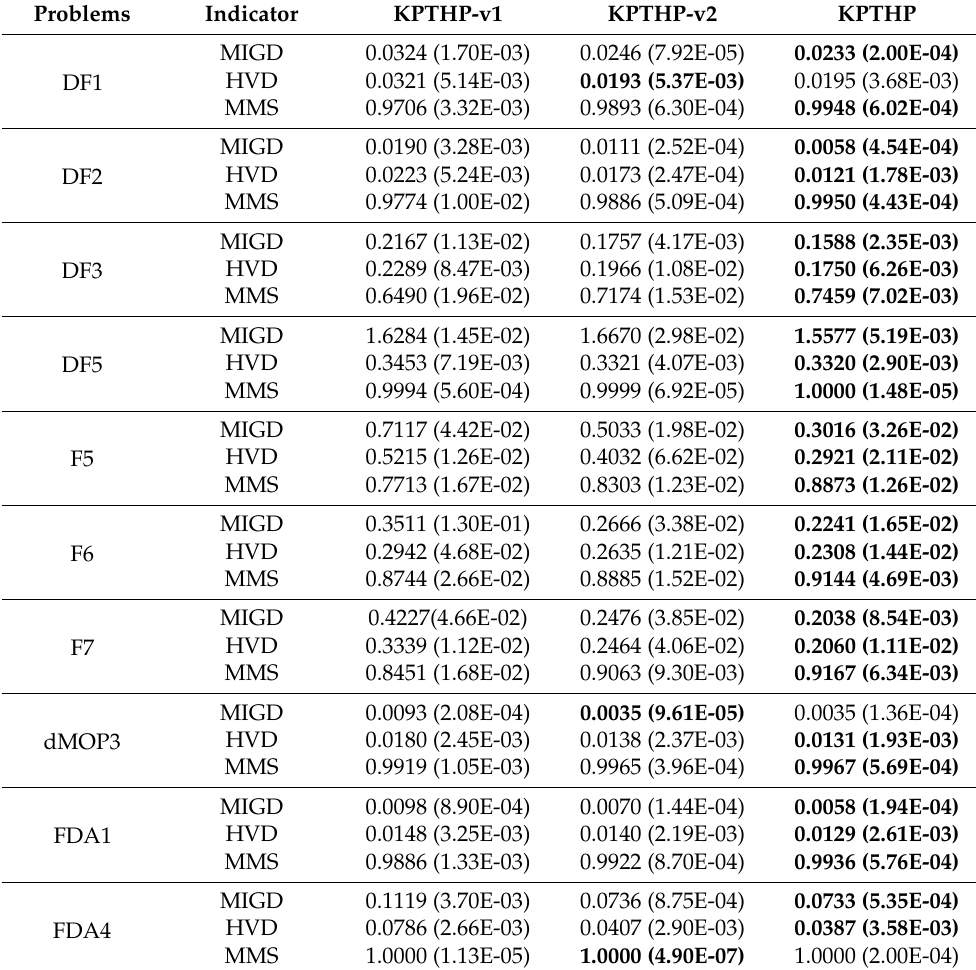
Table 9. Mean and SD of MIGD, HVD, and MMS indicators obtained by three algorithms.